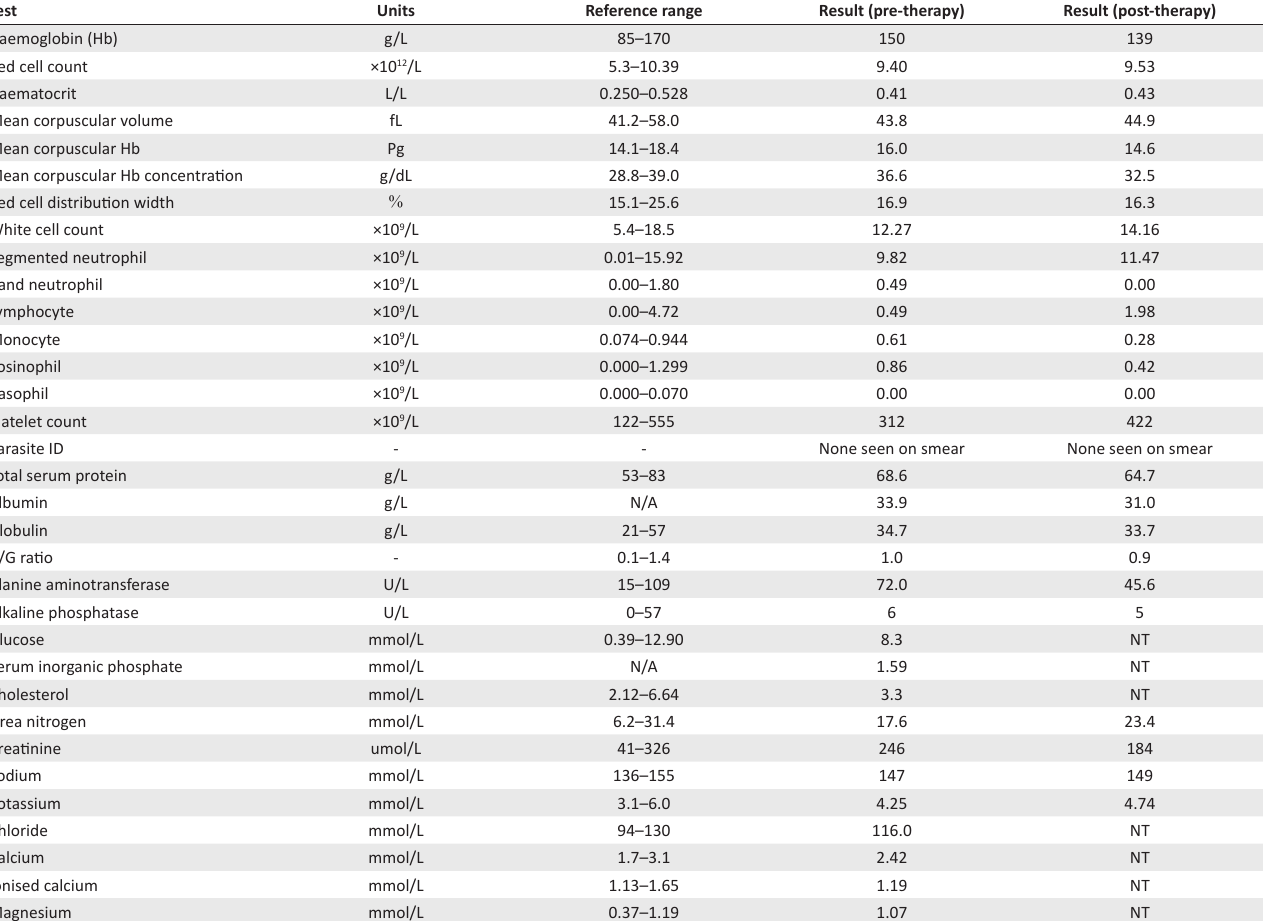
TABLE 1-A1: Diagnostic laboratory report for the lion, showing haematology, biochemistry and blood gas electrolyte values at the two times blood was taken for